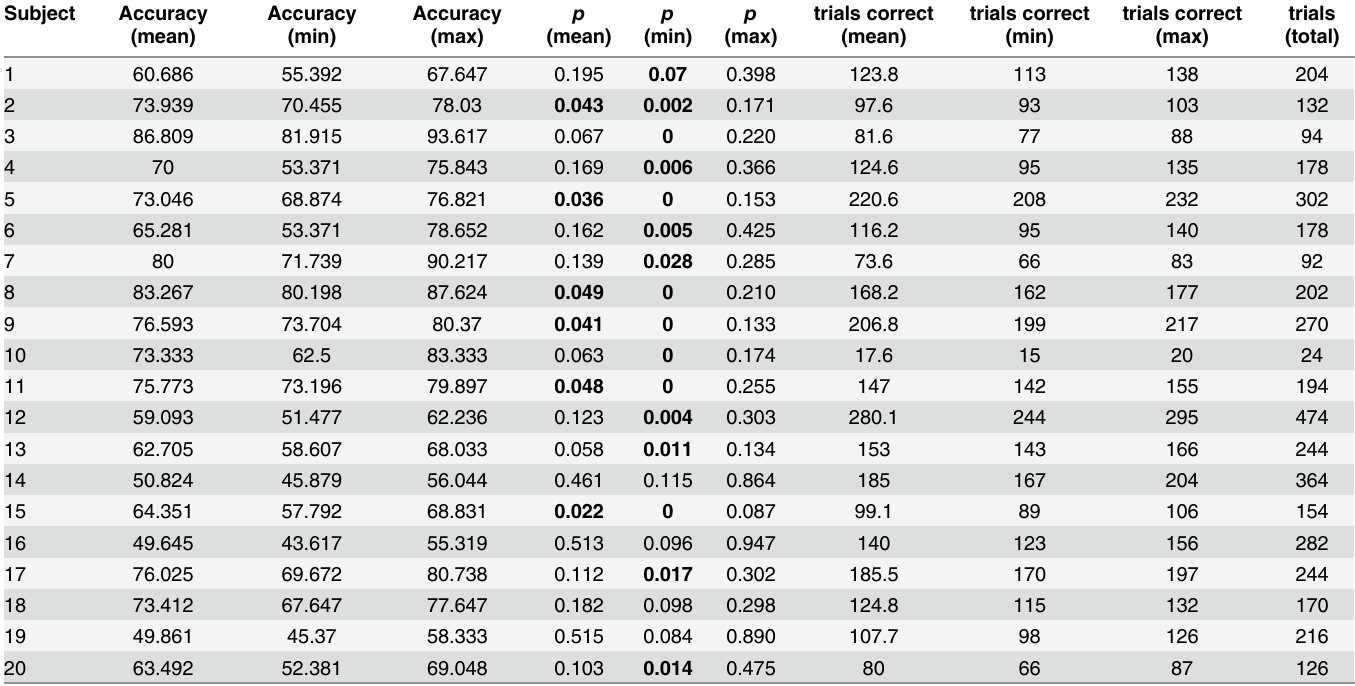
Table 11. Results Across Task Ne: Train Rotation, Classify